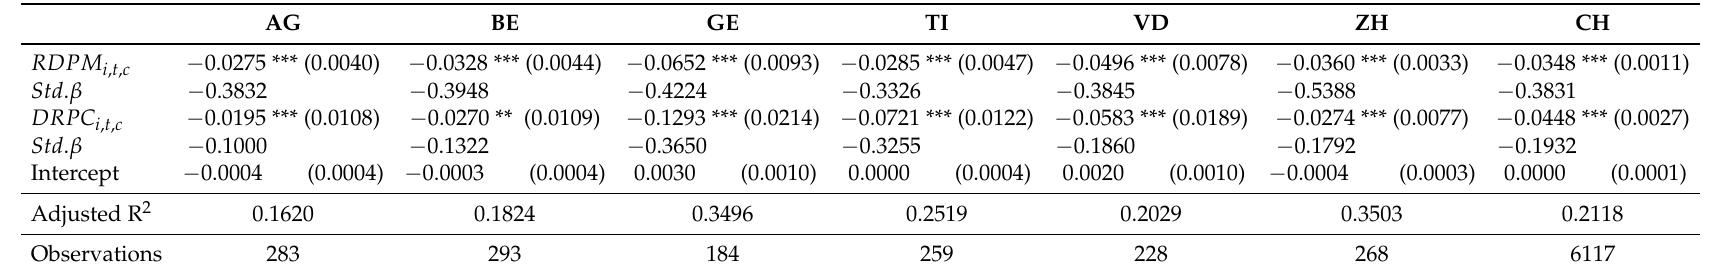
Table A4. Multivariate regression results ( R 2) with normally distributed